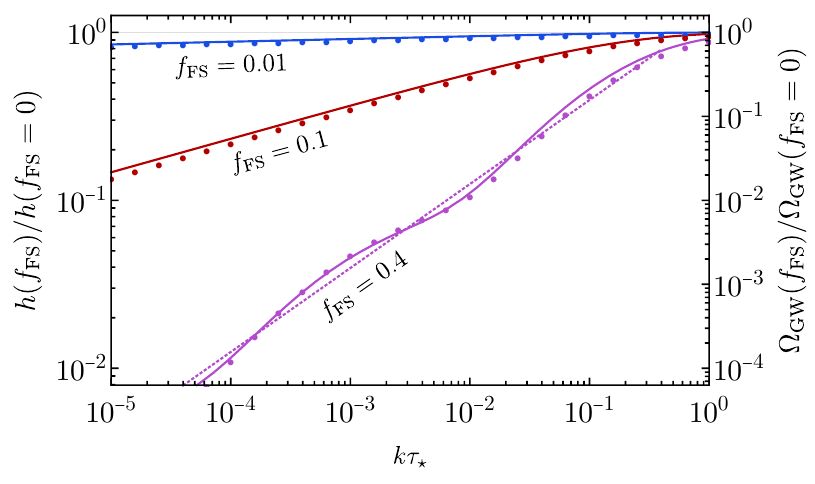
Figure 2 . The suppression effect of free streaming particles on the production of GWs, for free streaming fractions 0.01, 0.1 and 0.4 respectively. The dots are numerical data points while the solid lines are the analytical approximations. The dotted purple line is a k 4 scaling shown to highlight the oscillations taking